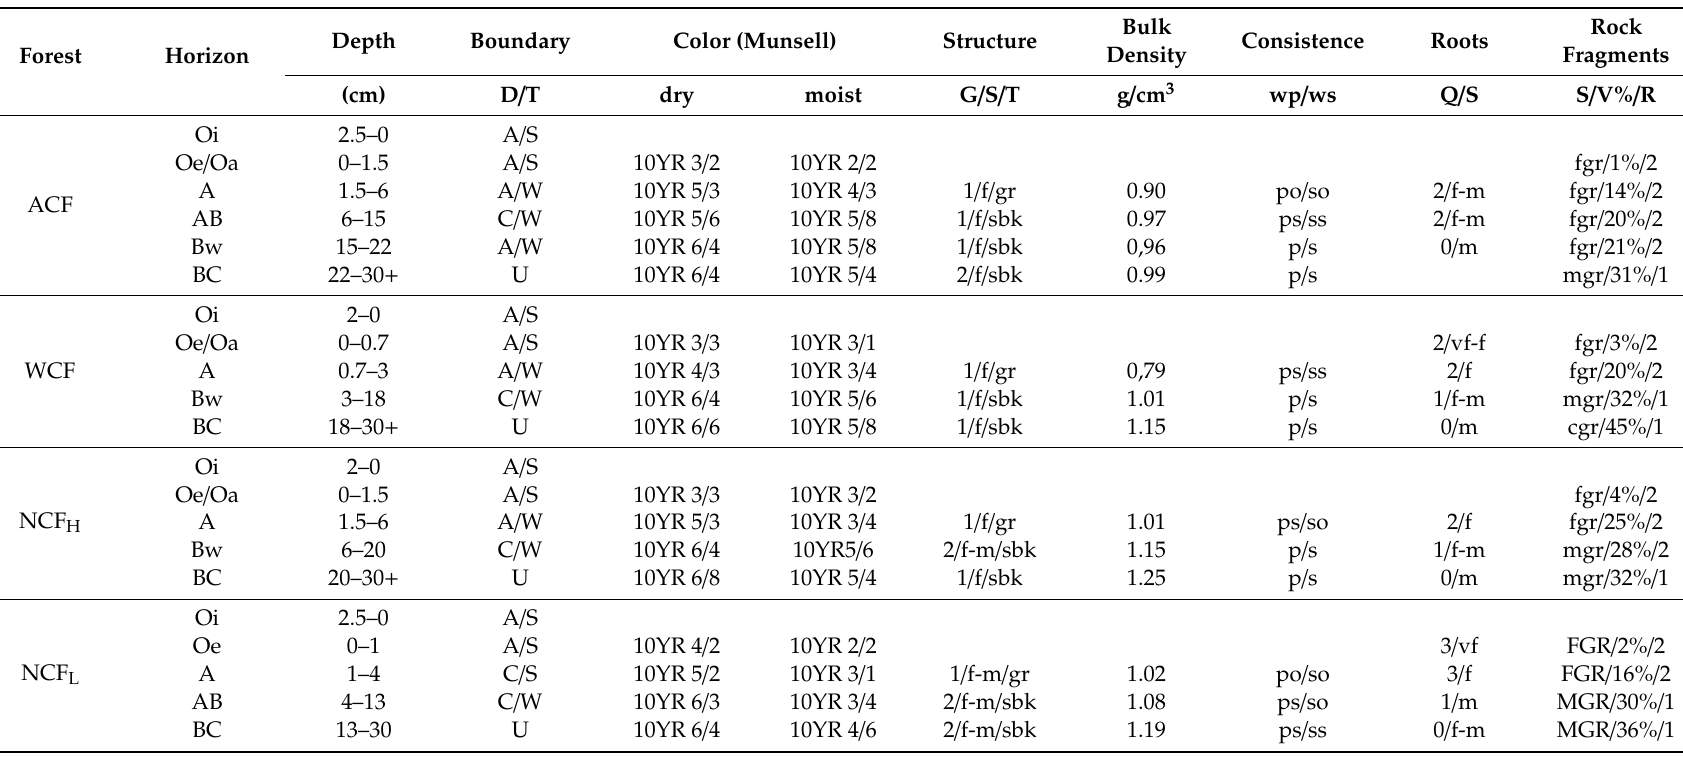
Table 1. Morphological characteristics of representative soil profiles dug in an abandoned chestnut forest (ACF), a chestnut forest for wood production with a tree density of 151 plants ha − 1 (WCF), a chestnut forest for nut production with a tree density of 120 plants ha − 1 (NCF H ) and a chestnut forest for nut production with a tree density of 98 plants ha − 1 (NCF L